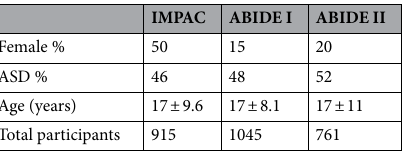
Table 3. Demographics of IMPAC participants, ABIDE I participants, and ABIDE II participants. Errors shown are standard